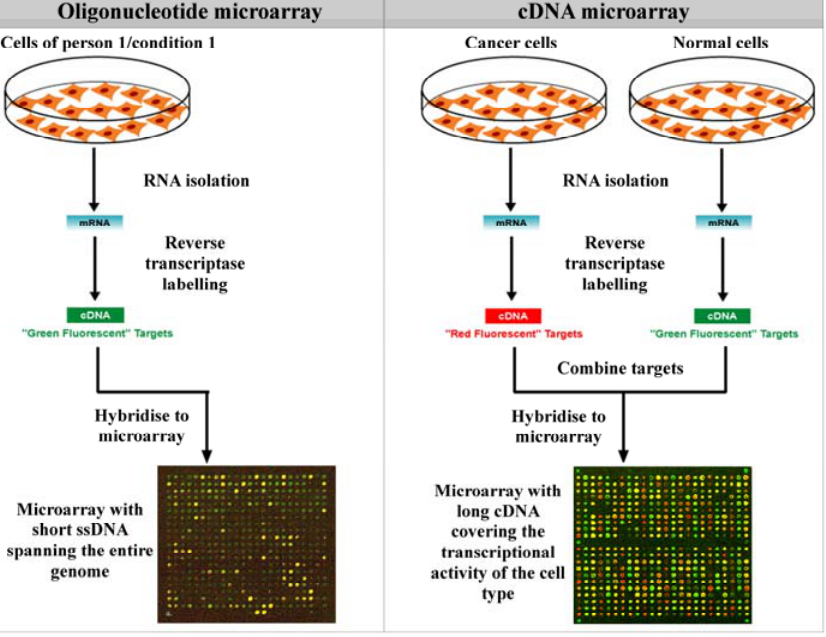
Figure 15. Schematic diagram of two types of microarrays. Left panel: An oligonucleotide microarray, modified with short oligonucleotide sequences covering the entire genome, gives information about the presence and absence of certain gene fragments. Each microarray is hybridised with target material of one condition. Right panel: A cDNA microarray, modified with longer cDNA sequences covering the expressional activity of a cell type, are used for gene expression analysis. Each microarray is hybridised with target material of two